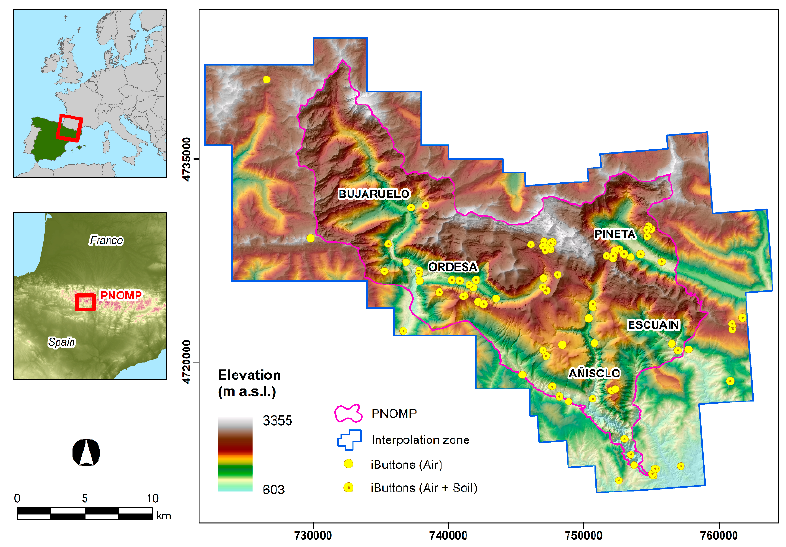
Figure 1. Study area on the south side of the Central Pyrenees: the Ordesa and Monte Perdido National Park (PNOMP), and its five valleys included. The yellow circles indicate the distribution of the iButtons to measure temperatures and relative